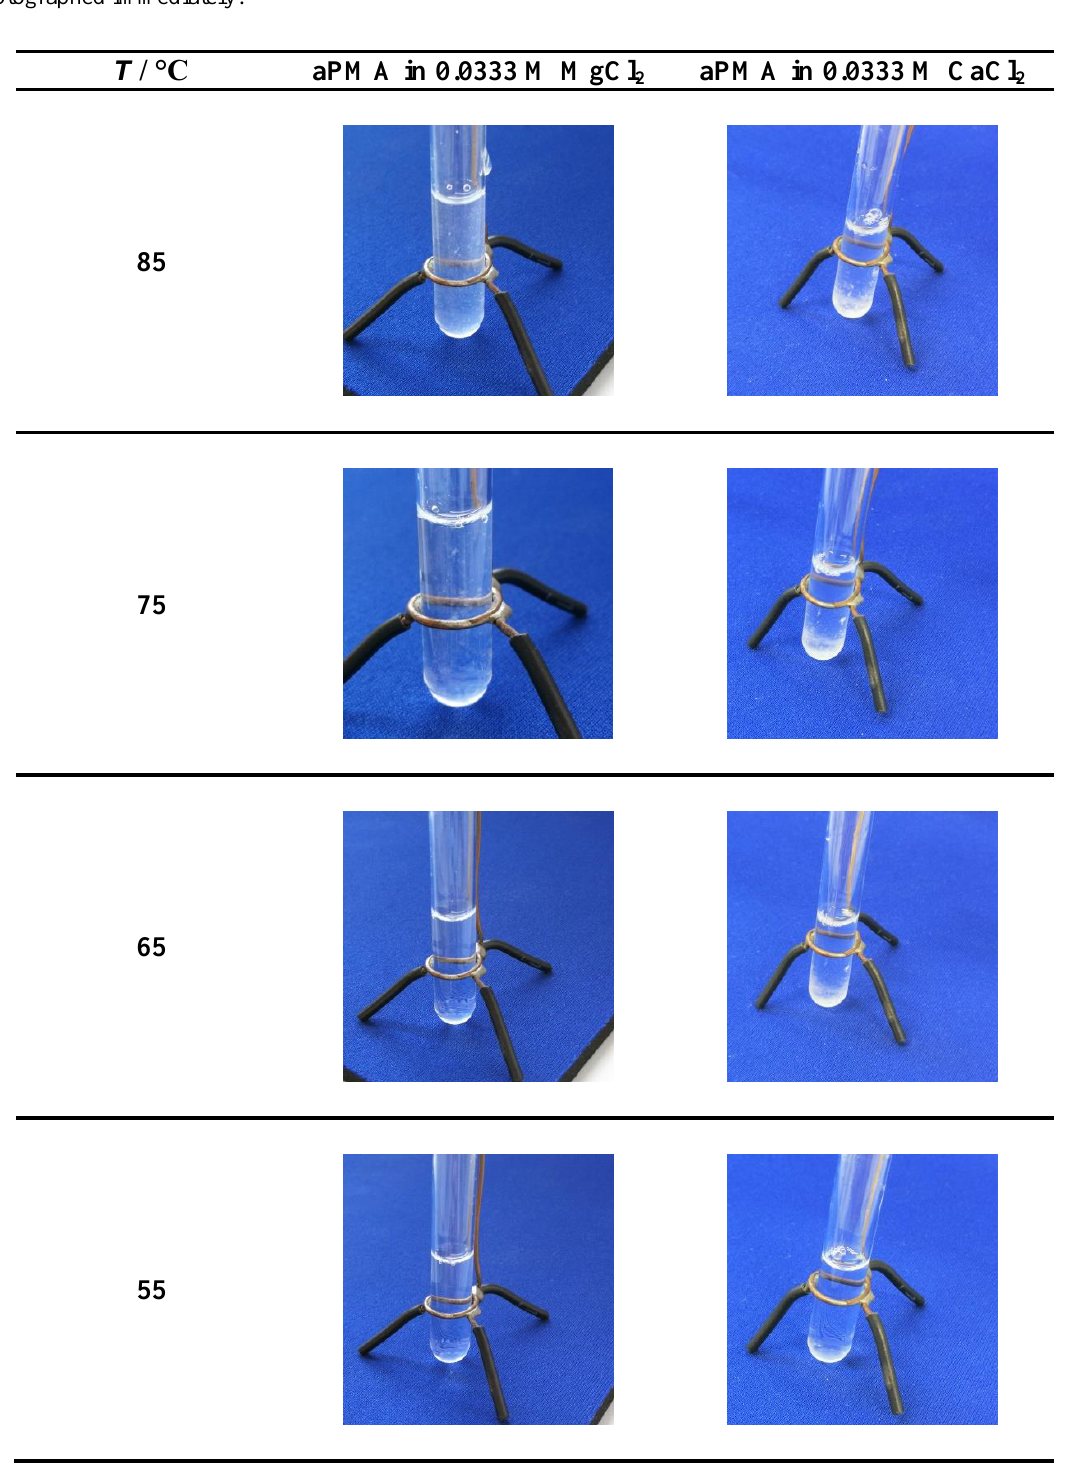
= 0.023 mol L -1 , α = 0) samples in the presence of MgCl p N